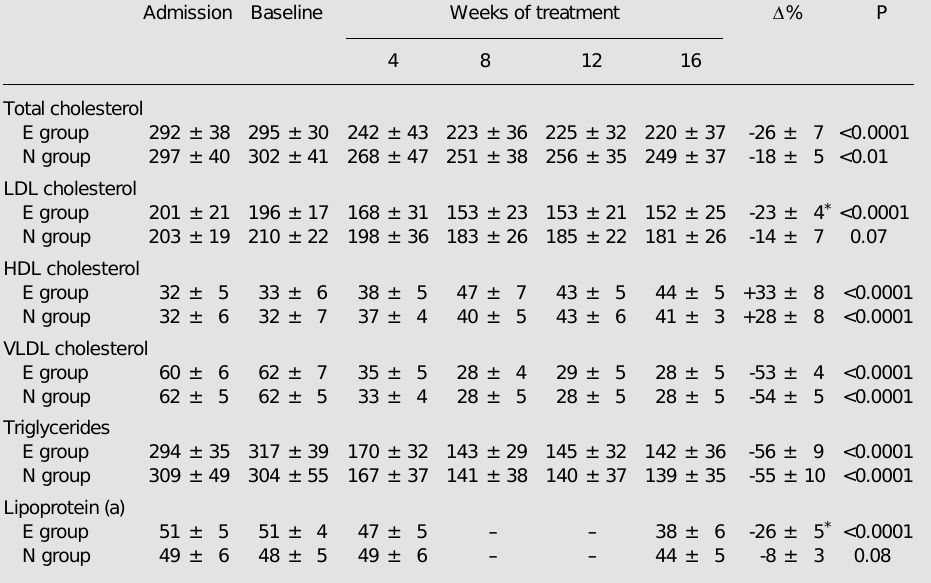
Table 2 - Plasma lipid and lipoprotein (a) concentrations at admission to the study, baseline concentrations and concentrations after treatment with etofibrate (E) or niacin (N). *P<0.05 compared to group N. Data are reported as means ± SD (mg/dl) and were analyzed by ANOVA. D %, Percent variation; HDL, high-density lipoprotein; LDL, low-density lipoprotein; VLDL, very-low-density lipopro-